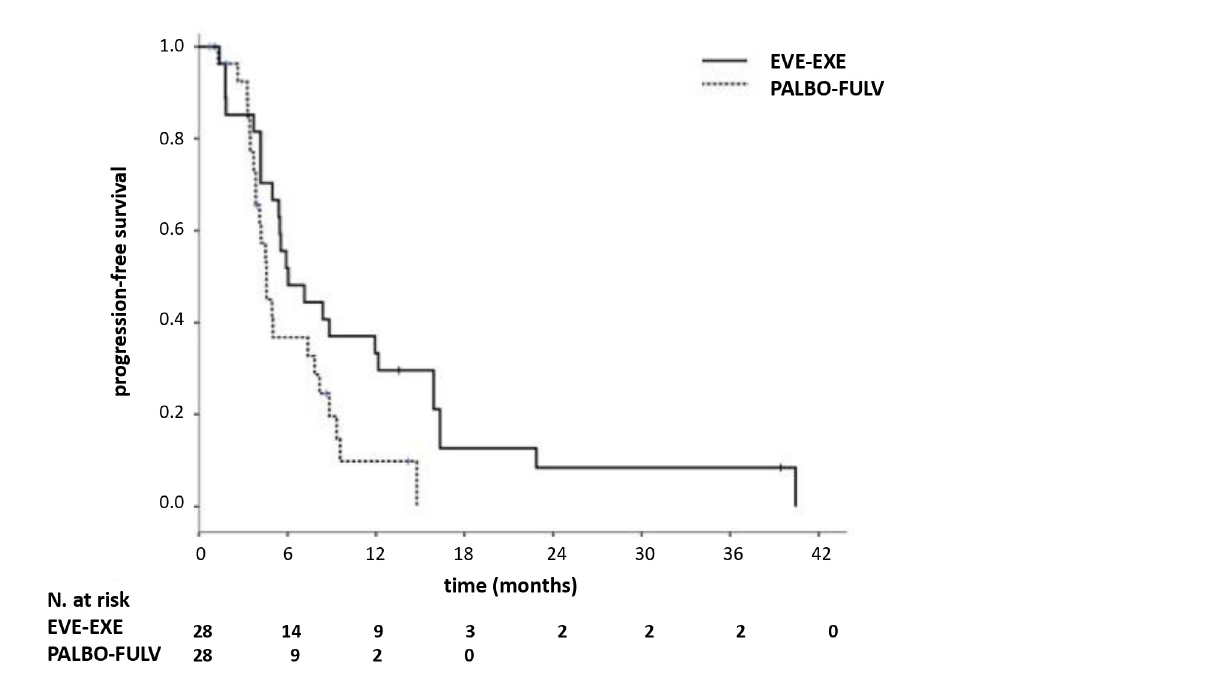
Figure 2. Progression-free survival (PFS) after propensity score adjustment. EVE: everolimus; EXE: exemestane; PALBO: palbociclib; FULV: fulvestrant.